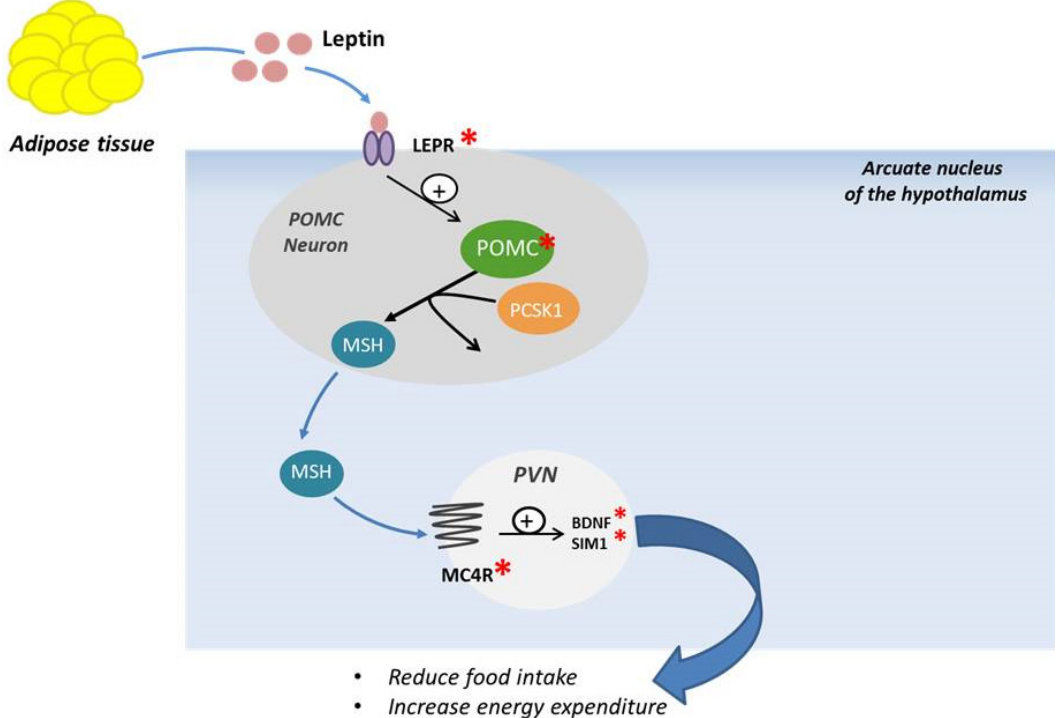
Figure 2. Schematic representation of POMC neuronal and melanocortin-4 receptor activation. LEPR: